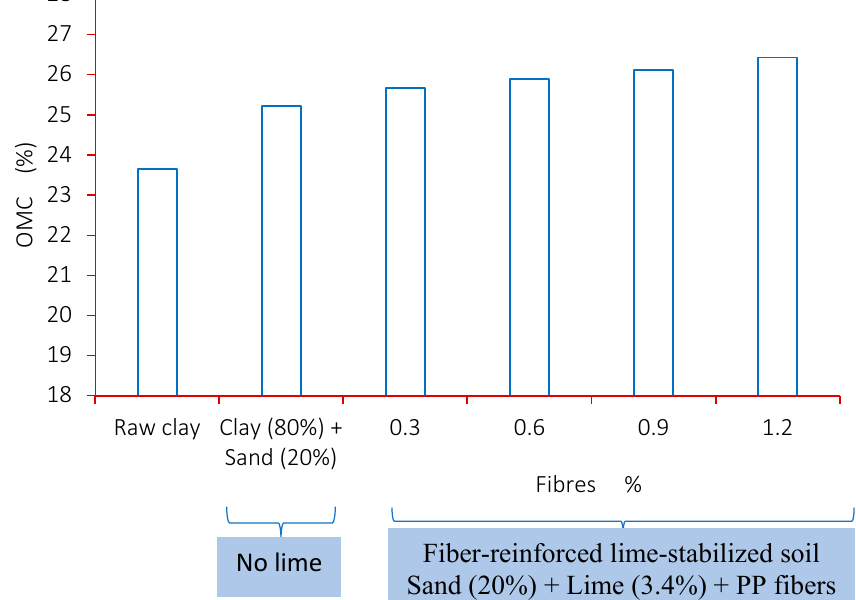
Figure 8. Optimum moisture content for different mixes.